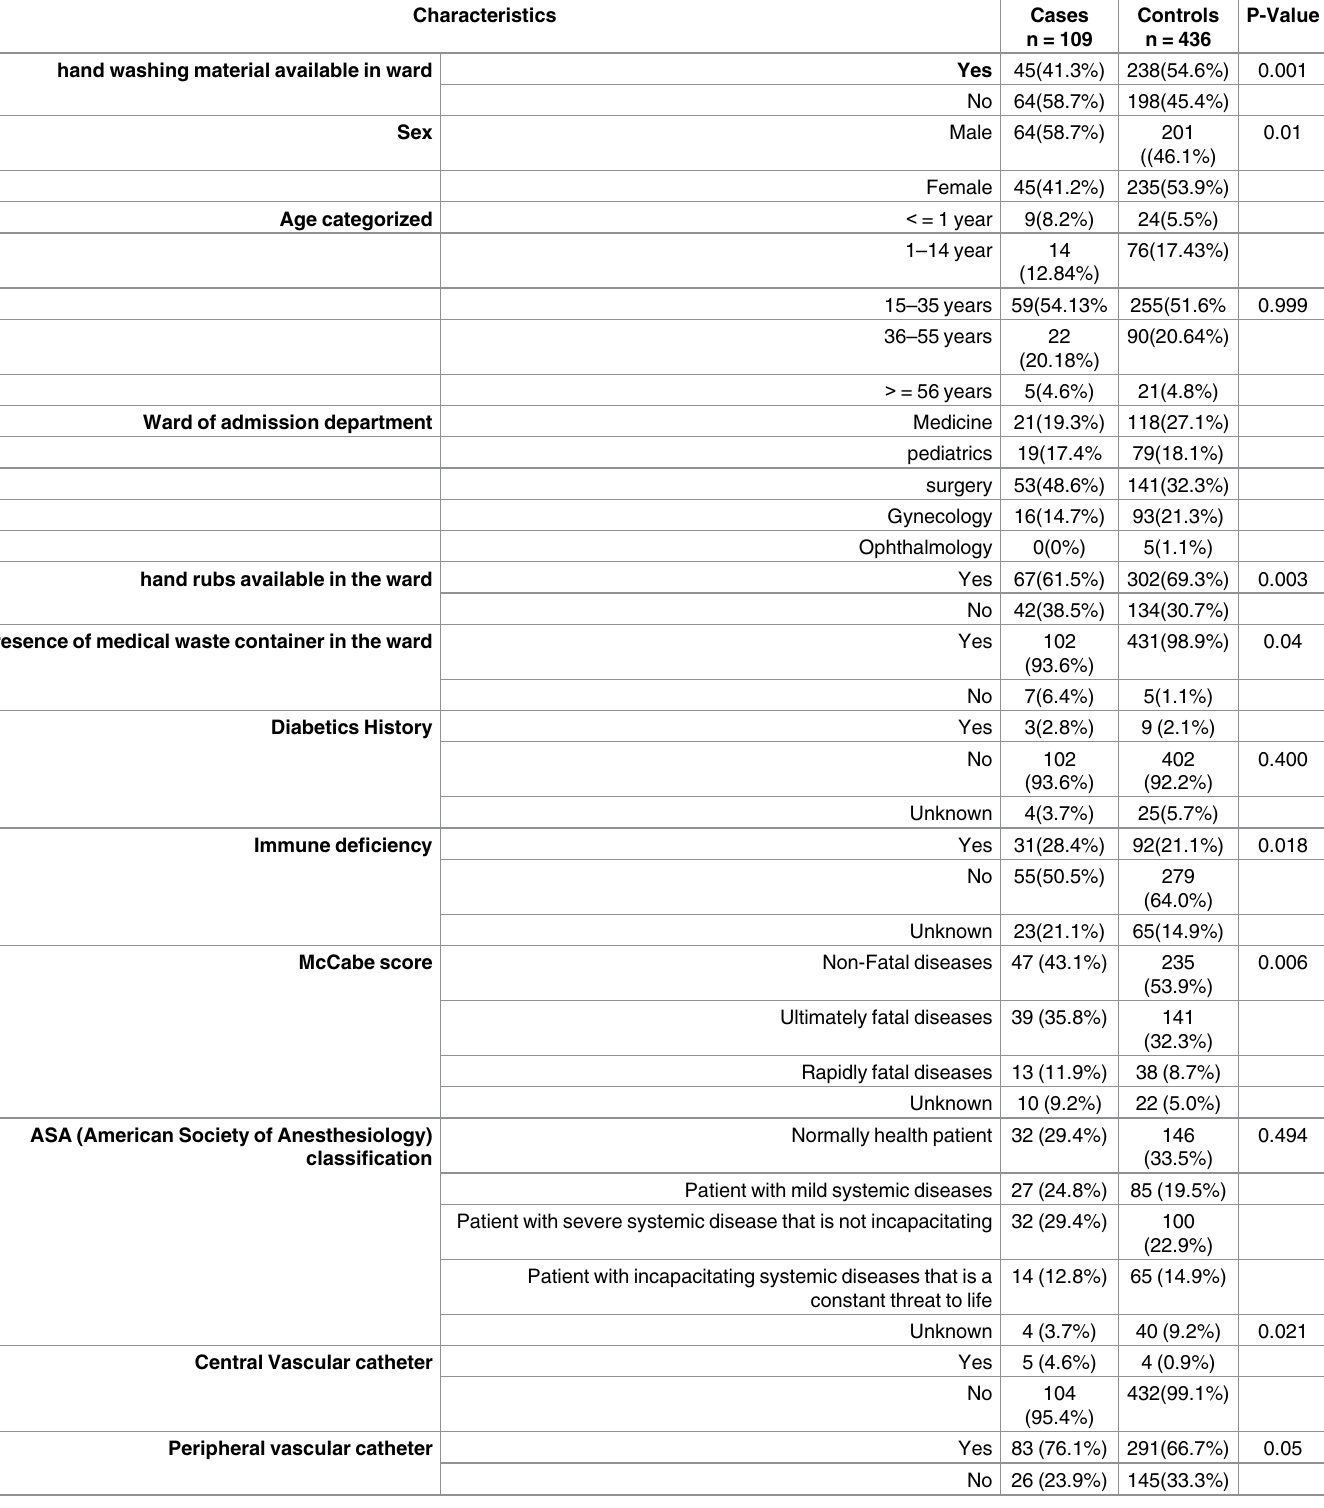
Table 1. Background characteristics of cases and controls, in teaching hospitals in Amhararegion, Ethiopia,